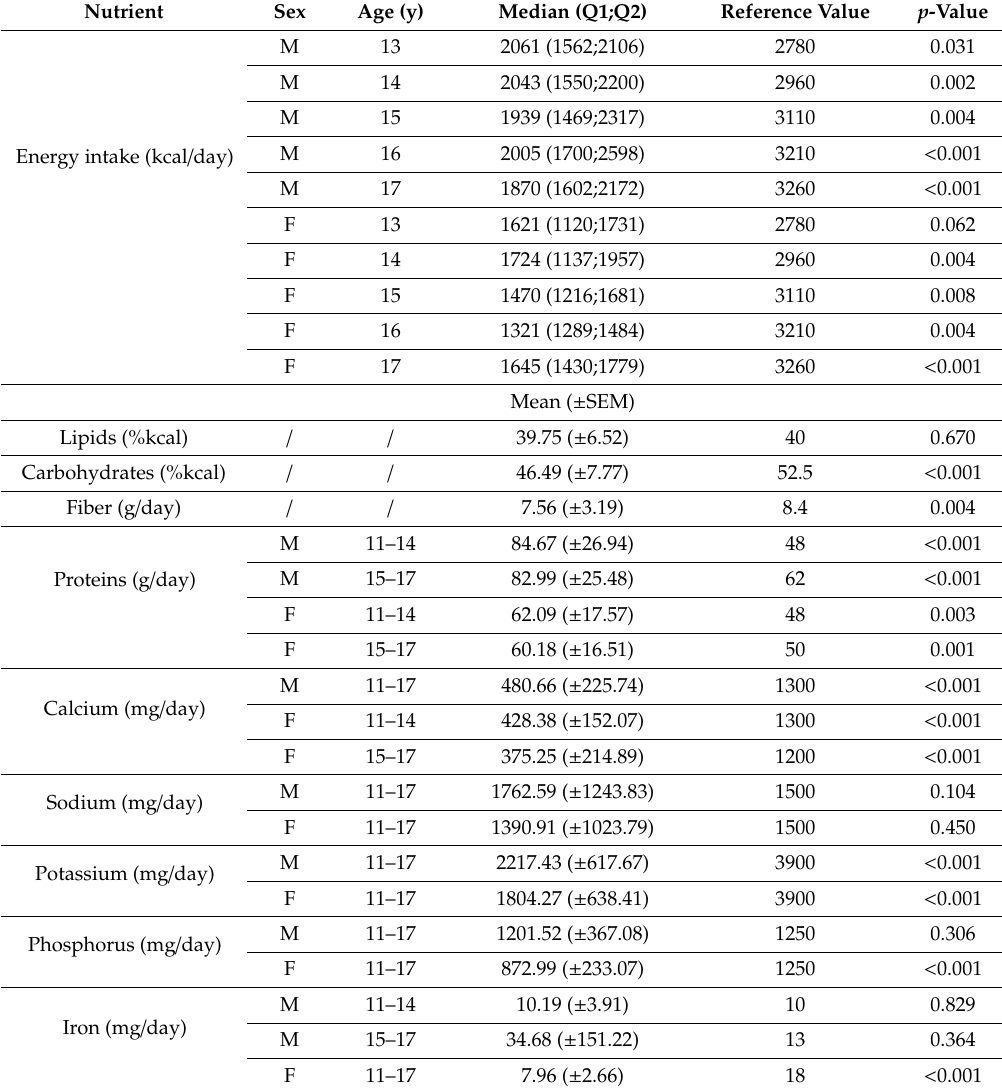
Table 4. Reported 3 days food intake compared with Italian